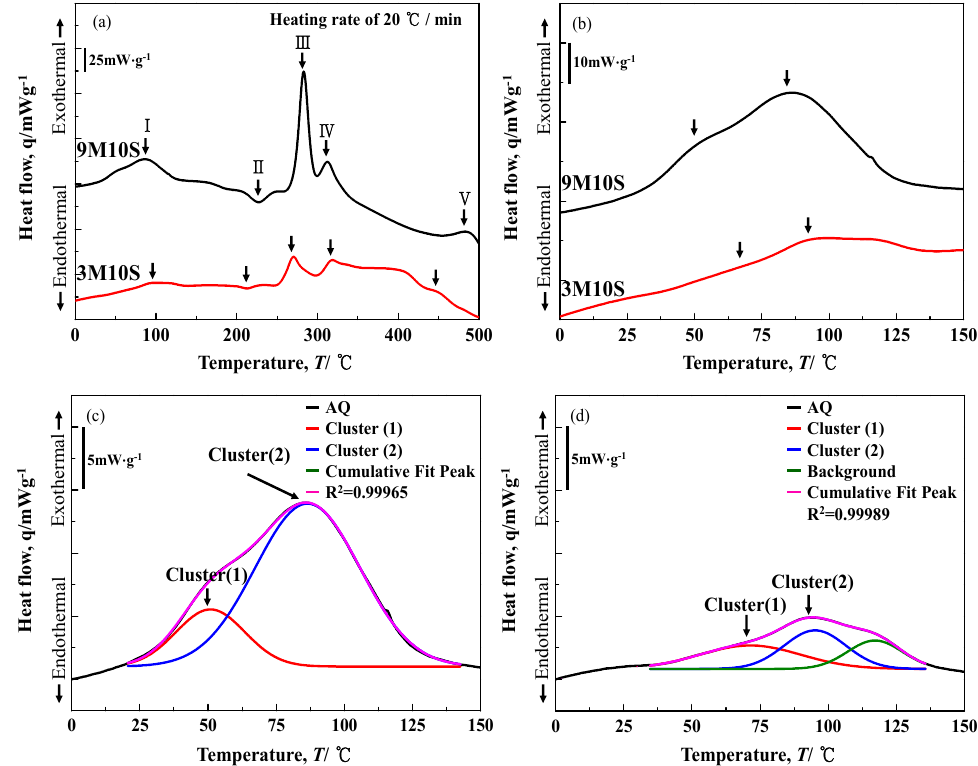
Figure 1. Differential scanning calorimetry (DSC) curves over the full range of the as-quenched specimens during a heating rate of 0.33 °C/s in the 9M10S ( a ) and 3M10S ( b ). The overlapped peaks were separated through the Gaussian function method for 9M10S ( c ) and 3M10S ( d ).